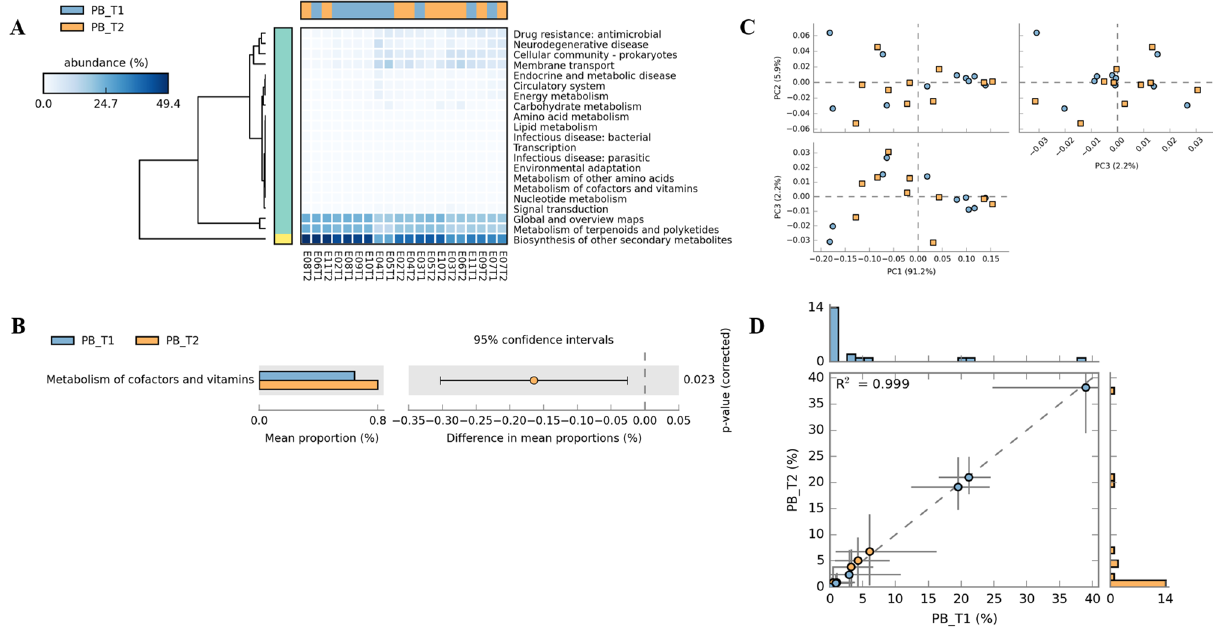
Figure 5. Metagenomic profile comparisons of metabolic pathways associated with PB group members determined using STAMP analysis (Level-2). A - Expression of all altered pathways. B - Positive differences between proportions denote greater abundances in the PB_T1 timepoint (blue), whereas negative differences between proportions show greater abundances in the PB_T2 timepoint (orange) for the given pathways. Corrected p -values were calculated based on two-sided Welch’s t-test no correction and Welch’s inverted CI method. Difference with a p -value of < 0.05 were considered to be significant. C - PCA plot determined from the proportion of reads assigned to each pathway within a sample. D - Profile scatter plot with histograms showing the proportion of genes and functional profile, relative to all assigned genes, within the PB group at both the time points.